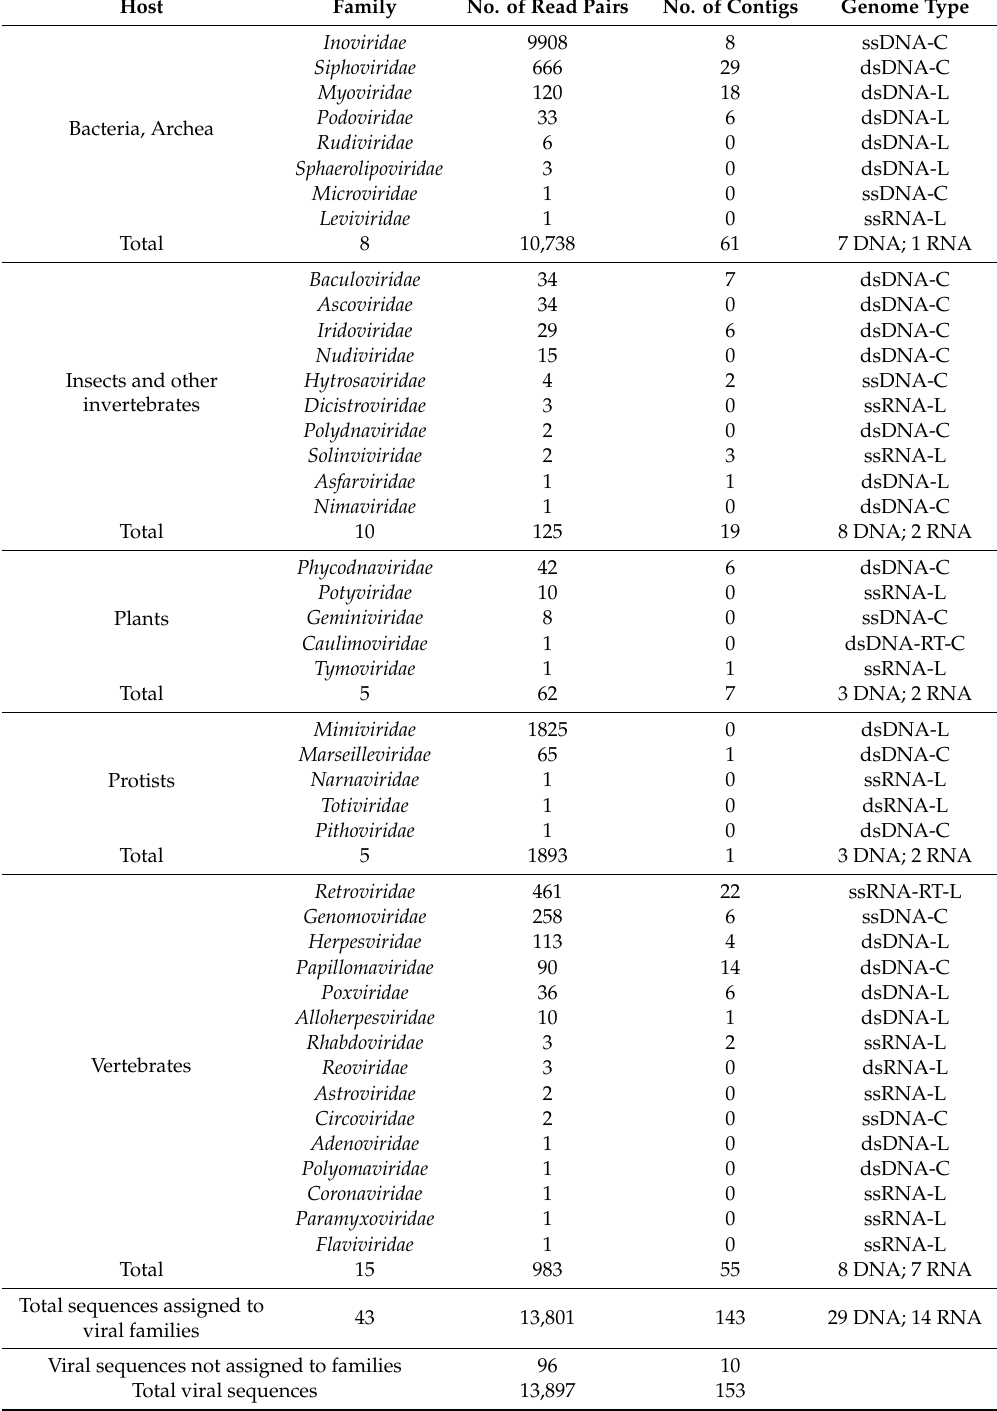
Table 1. Read pairs and contigs of virus families identified in anal and oral swab samples of Tadarida brasiliensis obtained by metagenomics using Illumina